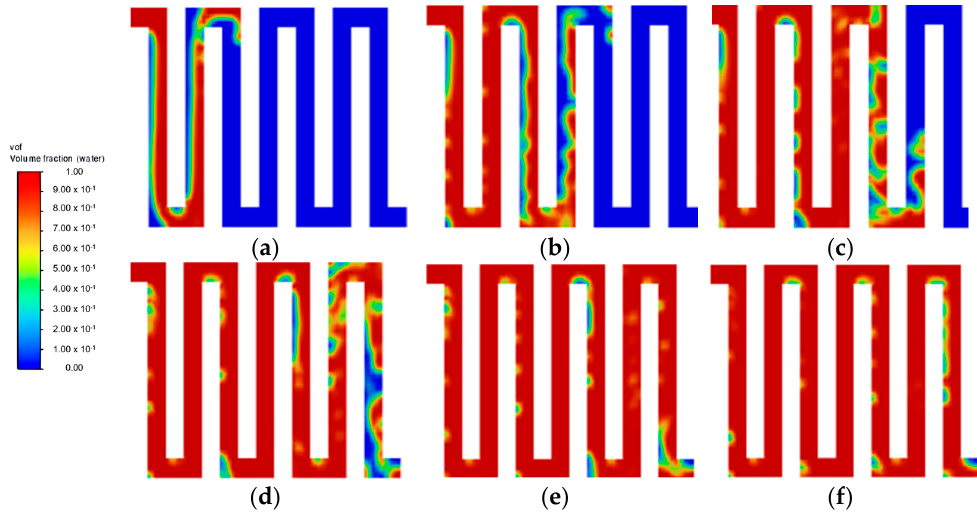
Figure 6. Serpentine flow field with velocity = 0.75 m ⋅ s − 1 ( a ) 0.05 s; ( b ) 0.10 s; ( c ) 0.15 s; ( d ) 0.20 s; ( e ) 0.25 s; and ( f ) 0.30 s.